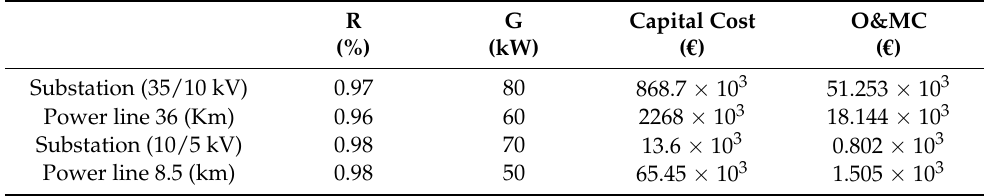
Table 6. Economic and technical parameters of substation and power line [57].